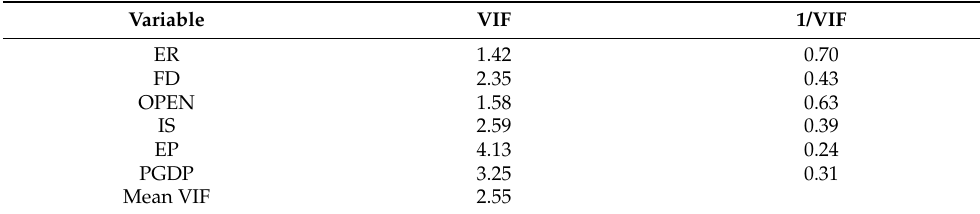
Table 3. Multicollinearity test results.